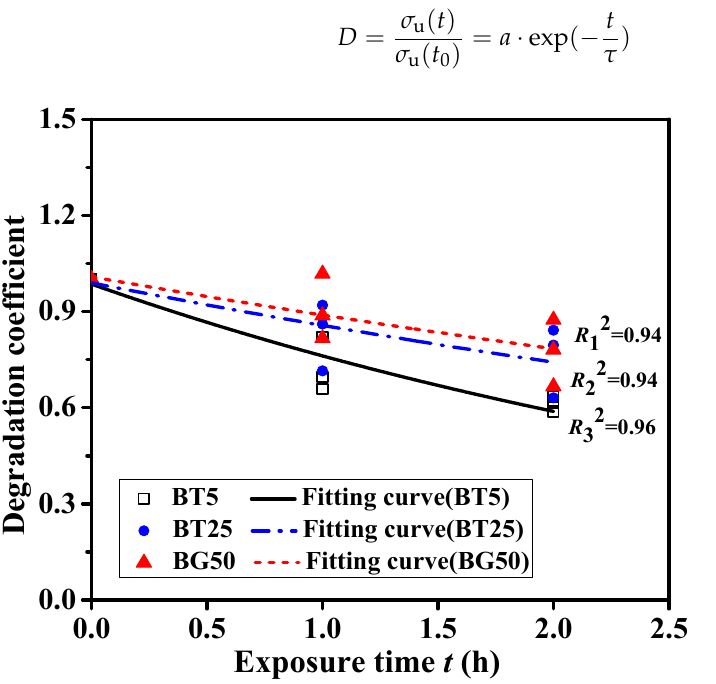
Figure 13. Prediction of strength degradation for the BGRM after exposure to elevated temperature. The strength degradations of the thin plates BT5, BT25, and BG50 at an elevated temperature of 300 ◦ C were fitted using the exponential model with high fitting accuracy (the tensile properties of the thin plate BG50F after exposure to elevated temperature were similar to that of the BG50, so the strength degradation of the BG50F was not fitted here), as shown in Equations (2)–(4). The fitting correlation coefficients R 2 were 0.94, 0.94, and 0.96,